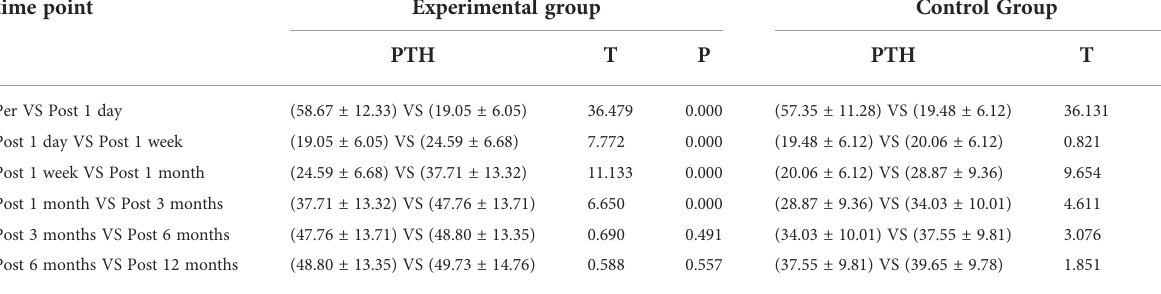
TABLE 3 Comparing the PTH between the two time points of the same group(pg/mL, X±S) time point